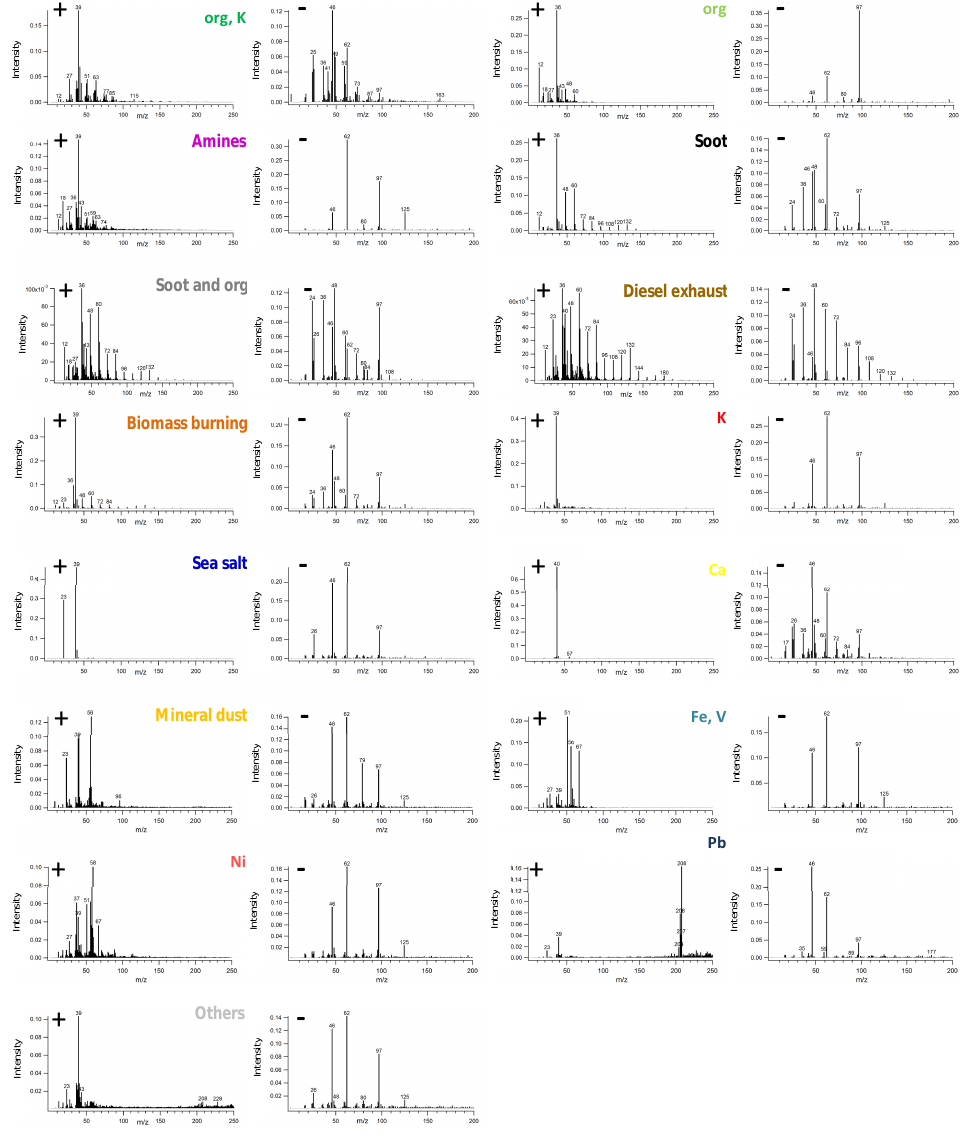
Figure 2. Mean positive (left) and negative (right) mass spectra representative of the particle types “org, K”, “org”, “amines”, “soot”, “soot and org”, “diesel exhaust”, “biomass burning”, “K”, “sea salt”, “Ca”, “mineral dust”, “Fe,V”, “Ni”, “Pb” (with the separation of the Pb isotopes clearly visible), and